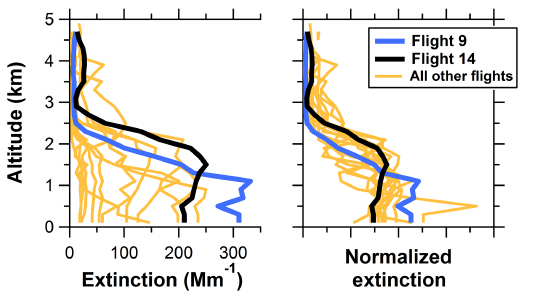
Figure 5. Average vertical profiles of aerosol extinction (at ambient RH and 532nm) for all flights, with flights 9 and 14 highlighted (left panel). These profiles can then be normalized to the total aerosol loading (AOD) to get the normalized vertical profile (right panel, arbitrary units).